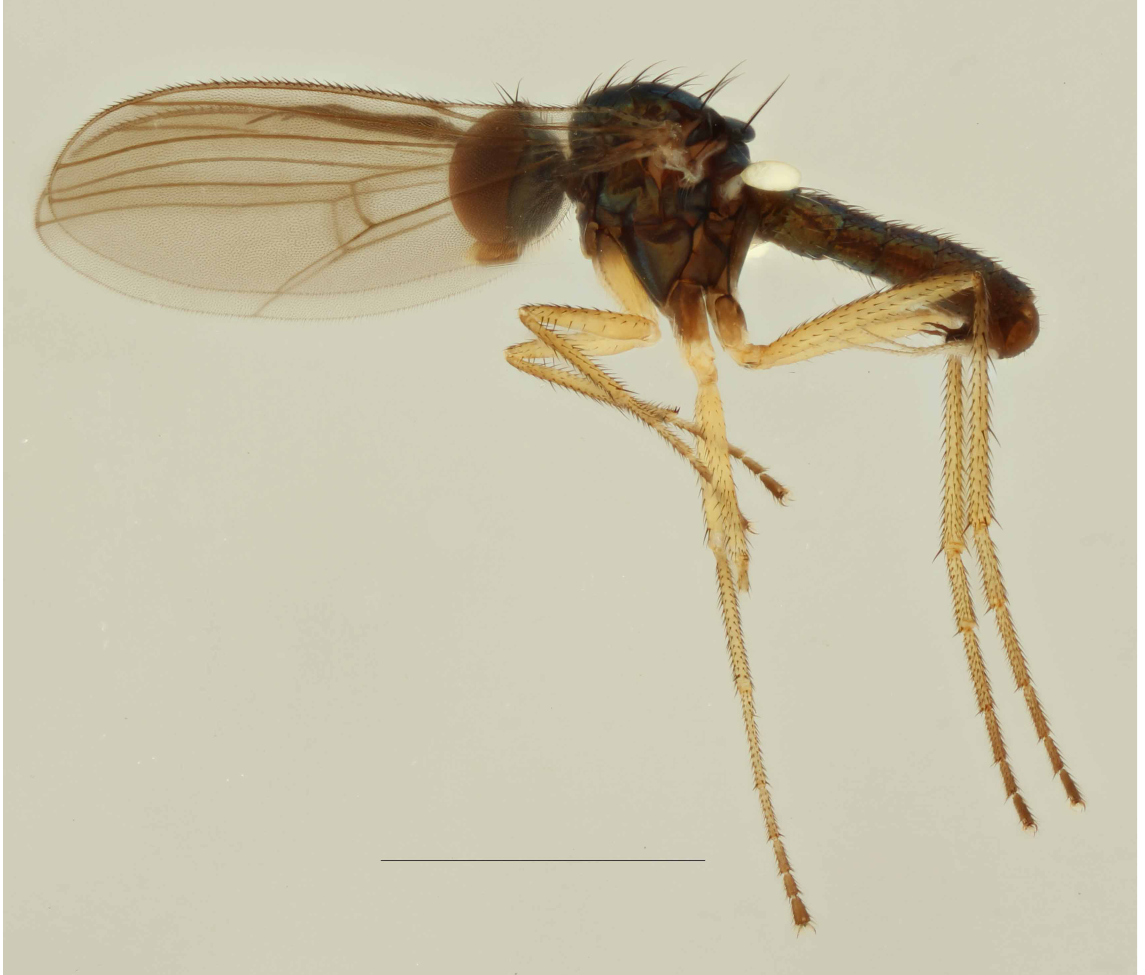
Fig. 3. Rhaphium spinulatum sp. nov., holotype, ♂, habitus (RBINS). Scale bar: 1 mm. (Photo credit Ms